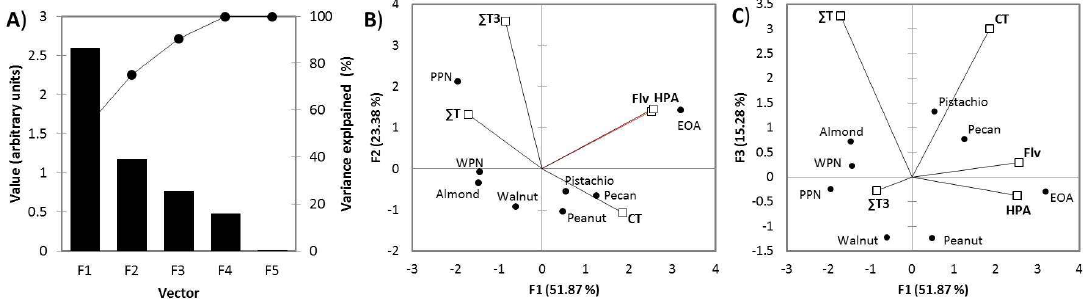
Figure 4. Principal component analysis (PCA). Scree ( A ) and bi-plots ( B , C ). Condensed tannins (CT), hydrophilic phenolic compounds (HPA), flavonoids (Flv)), monounsaturated (MUFAs) and polyunsaturated (PUFAs) fatty acids, tocopherols (T), and tocotrienols (T3). Emory oak acorn (EOA), and pink (PPN) and white (WPN) pine nut.